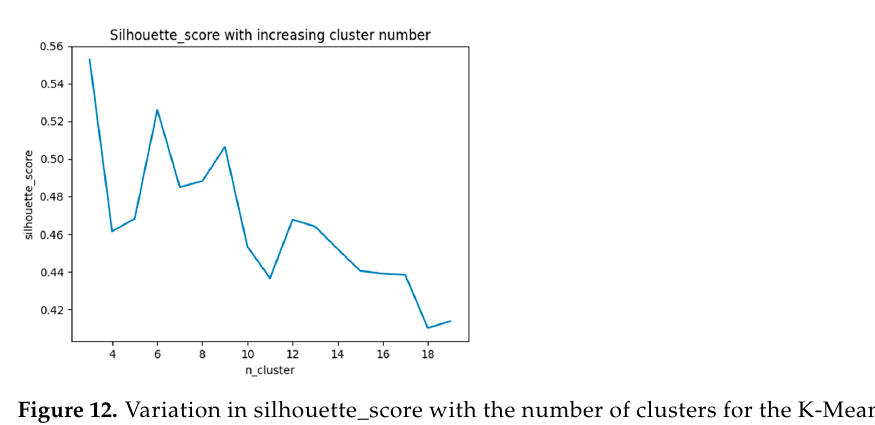
Figure 11. Variation in square sum of errors with the number of clusters for the K-Means++ clustering algorithm.